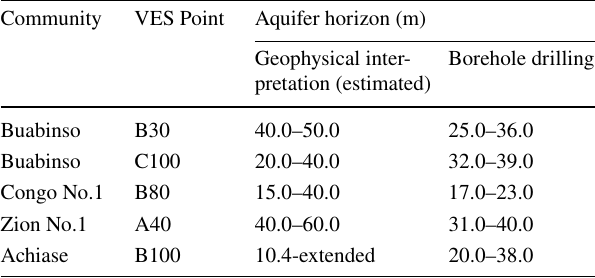
Table 2 Comparison between drilling and geophysical results (Okrah et al. 2012)